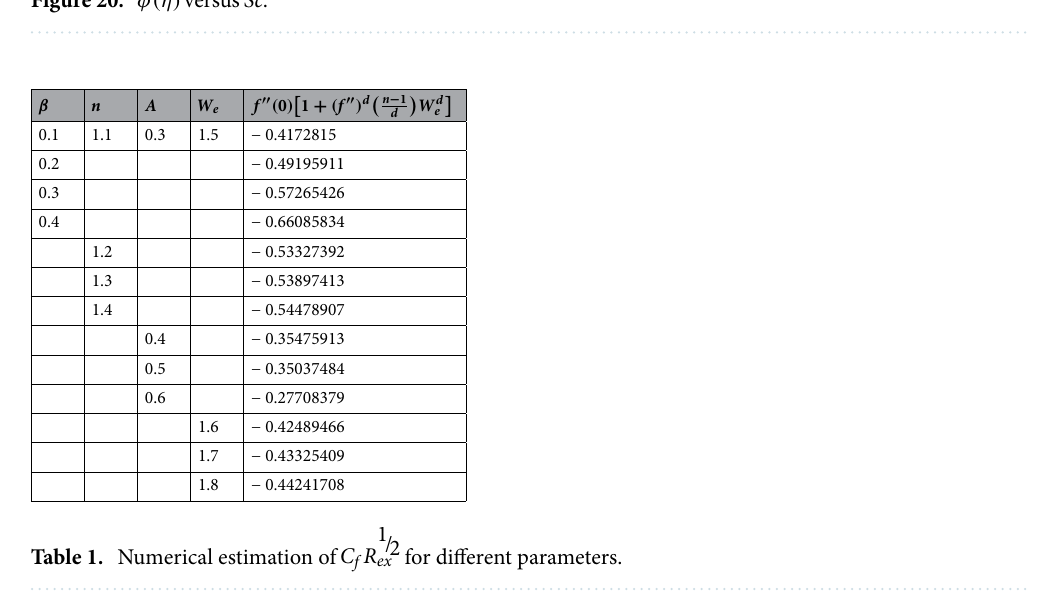
Figure 20. φ(η) versus Sc .